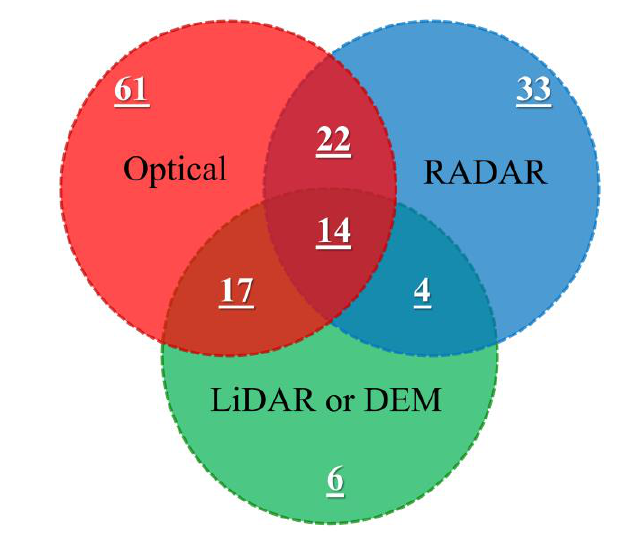
Figure 12. Type(s) of data used in wetland classification studies. 432